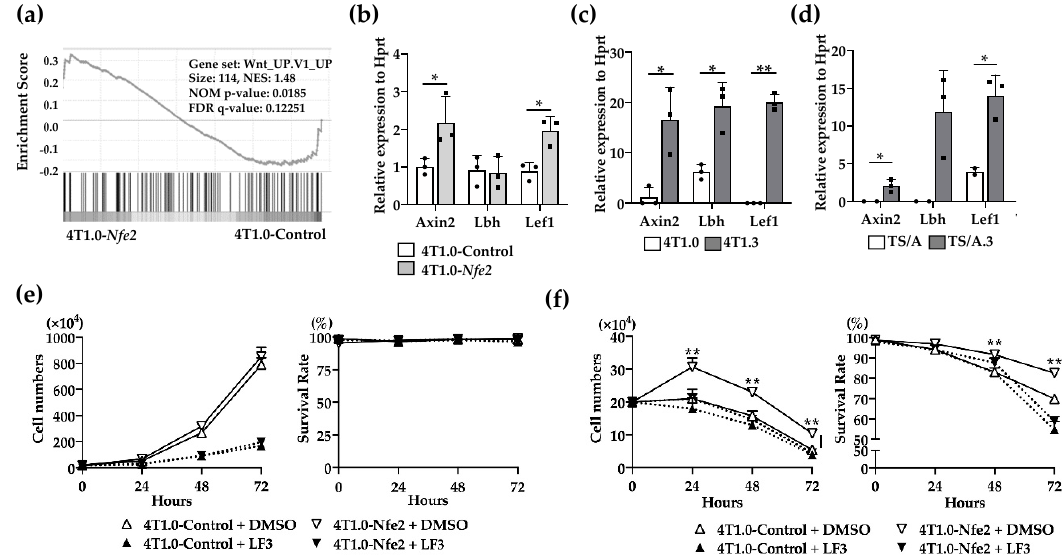
Figure 6. ( a ) Gene set enrichment analysis of Nfe2-expressing or control vector-transfected 4T1.0 cells in vitro. Total RNAs were extracted from Nfe2 -expressing or control vector-transfected 4T1.0 cells under in vitro culture conditions and were subjected to bulk RNA sequencing. ( b ) Determination of mRNA expression of Wnt-related molecules in Nfe2 -expressing or control vector-transfected 4T1.0 cells in vitro. Total RNAs were extracted from Nfe2 -expressing or control vector-transfected 4T1.0 cells under in vitro culture conditions. All values represent mean + SD ( n = 3). * p < 0.05. ( c ) Determination of mRNA expression of Wnt-related molecules in 4T1.0 or 4T1.3 cells, which grew in a bone cavity. Total RNAs were extracted from 4T1.3 cells or its parental 4T1.0 cells, which were isolated from a bone cavity at day 9 after intraosseous injection as described in the Materials and Methods section. Comparative CT values were calculated by normalizing to each value of 4T1.0 cells cultured under in vitro conditions. All values represent mean + SD ( n = 3). * p < 0.05, ** p < 0.01. ( d ) Determination of mRNA expression of Wnt-related molecules in TS / A or TS / A.3 cells, which grew in a bone cavity. Total RNAs were extracted from TS / A.3 cells or its parental TS / A cells, which were isolated from a bone cavity at day 9 after intraosseous injection. Comparative CT value were calculated by normalizing to each value of TS / A cells cultured under in vitro conditions. All values represent mean + SD ( n = 2 to 3). * p < 0.05. ( e , f ) In vitro proliferation rates of Nfe2 -expressing or control vector-transfected 4T1.0 cells in the presence of LF3 under normoxic ( e ) or hypoxic and anchorage-independent conditions ( f ). Each of the cell lines were cultured with LF3 or vehicle control, DMSO, under normoxic (20% O 2 ) or hypoxic (1% O 2 ) and anchorage-independent conditions, respectively. Cell numbers and survival rates were determined by using trypan blue exclusion assay. All values represent mean + SD ( n = 3). ** p <